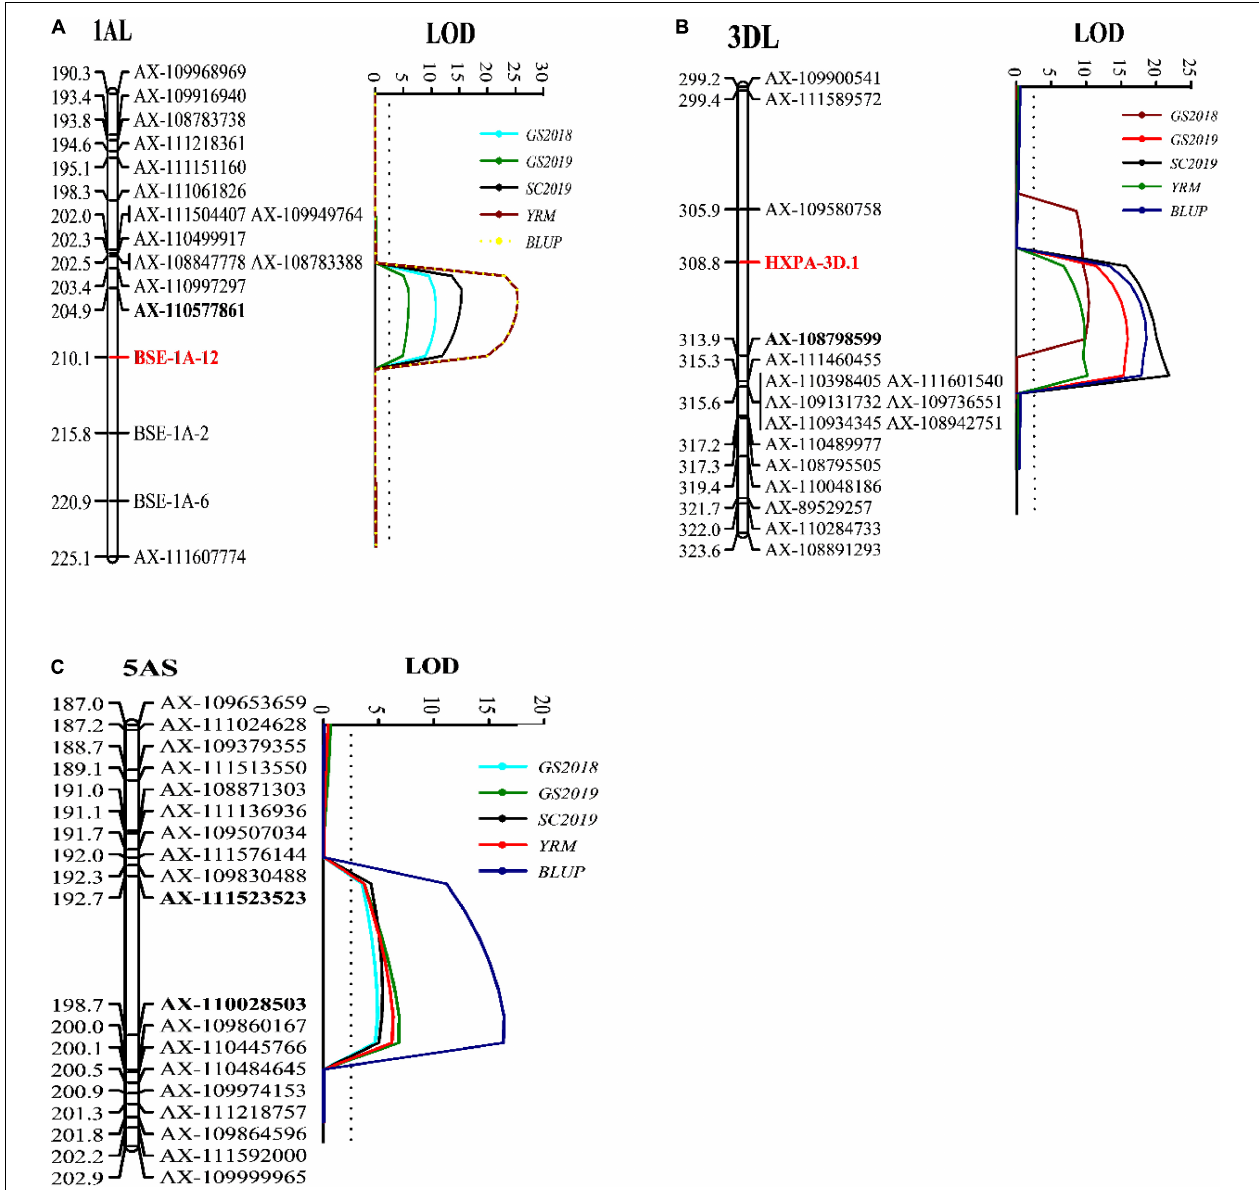
FIGURE 3 | Likelihood plots of quantitative trait loci (QTL) for adult plant resistance to stripe rust on chromosomes 1AL (A) after adding three KASP markers BSE-1A-2 , BSE-1A-6, and BSE-1A-12 , 3DL (B) after adding KASP marker HXPA-3D and 5AS (C) identified by IciMapping 4.1 in the Huixianhong/Pascal RIL population. The significant LOD threshold was based on 1,000 permutations. Positions (in cM) of the molecular markers along chromosomes are shown on the vertical axes using cumulated genetic distances. KASP markers BSE-1A-2 , BSE-1A-6, and BSE-1A-12 near QYr.gaas-1AL were designed based on the SNP of BSE-Seq in the interval of original marker AX-111218361—AX-110577861 . New marker BSE-1A-12 and SNP marker AX-110577861 were closely linked with QYr.gaas-1AL identified in the present study. we converted SNP marker AX-109580758 as a KASP marker named HXPA-3D to detect 220 RIL families. KASP marker HXPA-3D was closely linked with QYr.gaas-3DL identified in the present study. GS2018, final stripe rust severity during Gansu 2017–2018; GS2019, final stripe rust severity, during Gansu 2018–2019; SC2019, final stripe rust severity during Sichuan 2018–2019; YRM, the mean final disease severity of each season; BLUP, best linear unbiased